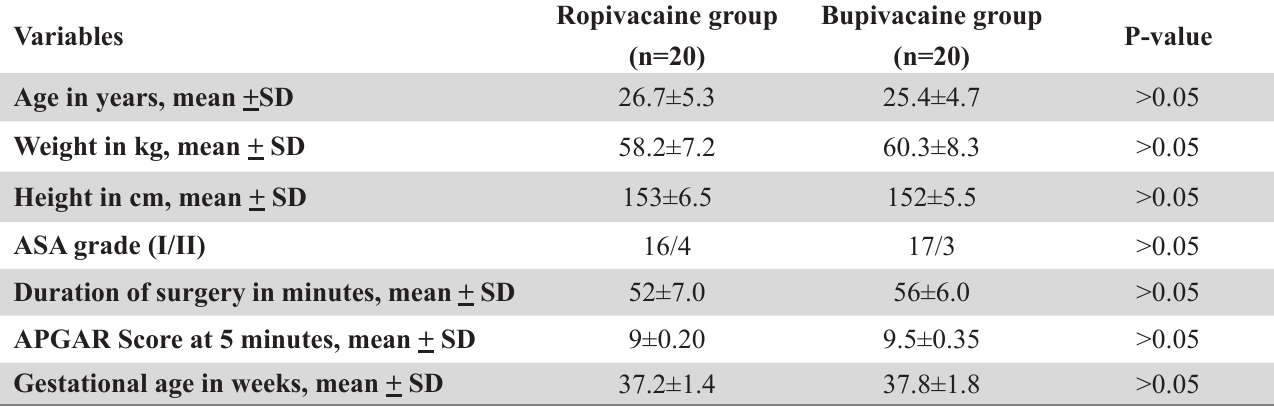
Table 1. Comparison of demographic profile, clinical characteristics and neonatal outcome between the study groups (N=40) Variables